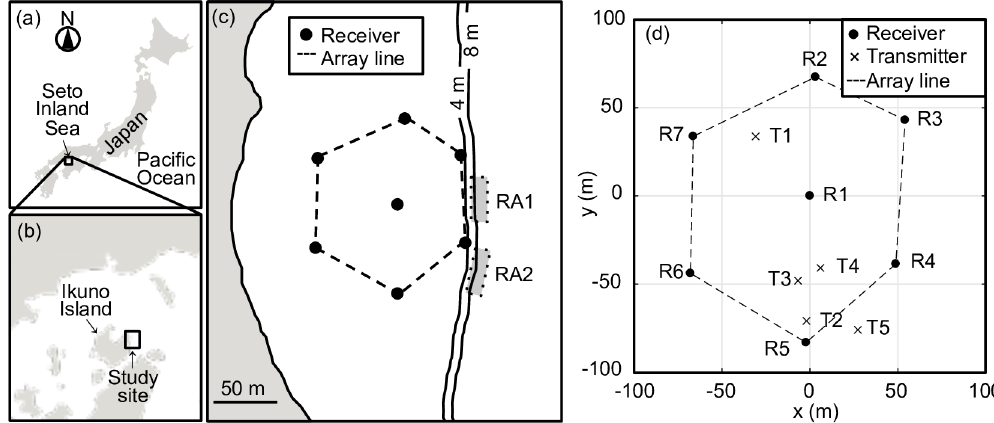
Fig 1. Acoustic array of seven receivers and transmitters for the experiment deployed off Ikuno Island, central Seto Inland Sea, southwestern Japan. (a)–(c) The array line represents the boundary between the outside and inside of the array. Vertical lines denoted by 4 m and 8 m represent the depth contour. There were two rocky areas (RA1 and RA2) on the east side of the array, where the Siebold’s wrasses used as specimens in this study were caught. (d) Seven receivers (R) and five transmitters (T) fixed on the seafloor. Horizontal and vertical axes denote the relative coordinate axes, adjusted to the central receiver (R1) of the